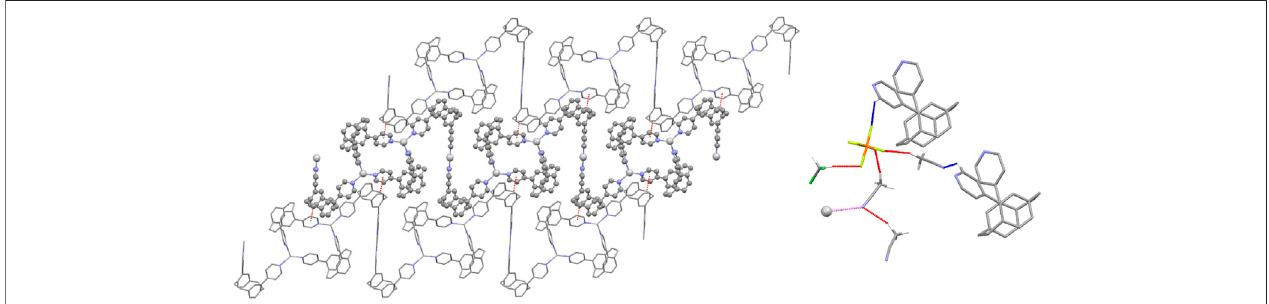
FIGURE 2 | Representations of the intermolecular interactions in the solid-state structure of Ag-pCp. (Left) View of a two-dimensional sheet in the (1 1 1) plane formed by C-H · π interactions (shown red) linking adjacent chains. The central chain is highlighted for clarity. (Right) View of the weakly interacting T-shaped motif (interactions shown red) formed by solvent and anion. Links from the motif to polymer chains are shown for both C-H ··· A (shown blue) and Ag ··· N (shown pink) interactions.